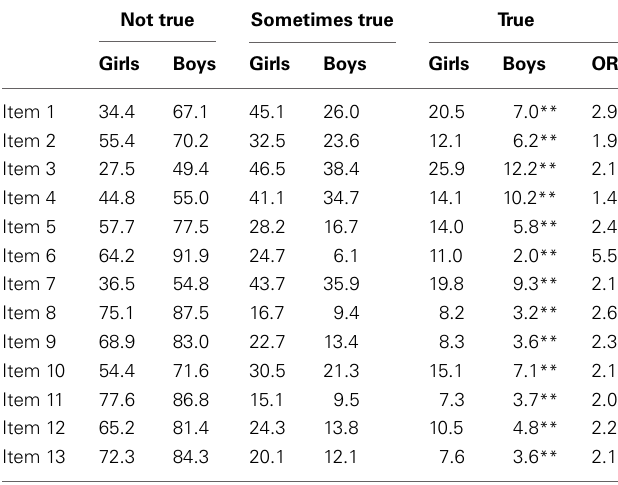
Table 3 | Percentage of girls and boys with a given response on the SMFQ